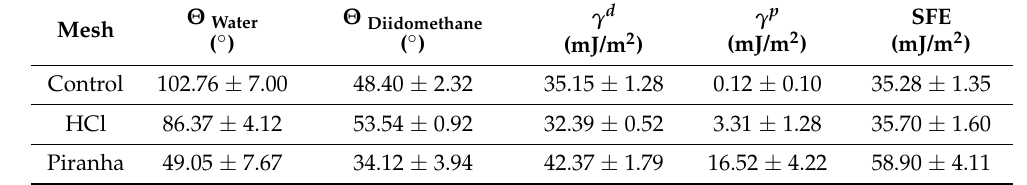
Table 3. Contact angles and components of the surface free energy for the differently passivated meshes.